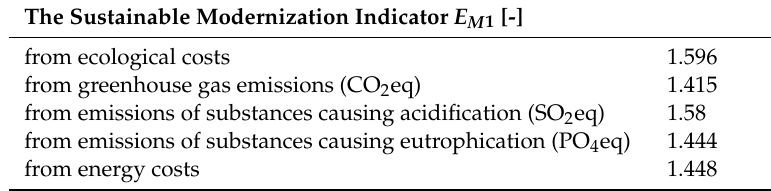
Table 6. Values of the sustainable modernization